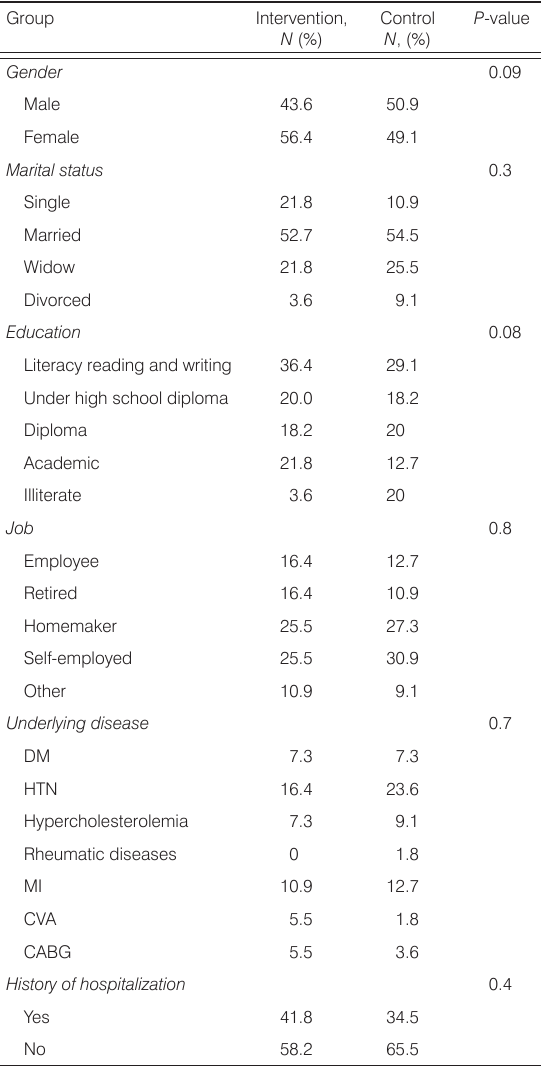
Table 1. Demographic characteristics of the intervention and control